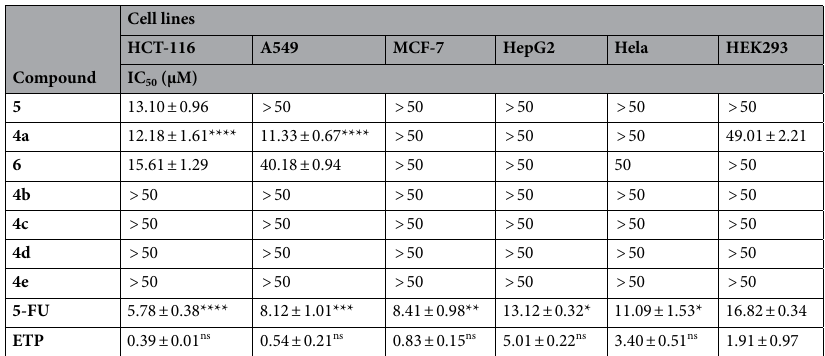
Table 1. Cytotoxic activity of tetrahydroquinoline derivatives against various cancer and normal cells presented as an IC 50 value referring to the concentration that inhibits 50% of cell growth. Data are expressed as the mean ± SD (µM) of n = 3 independent experiments. **** p < 0.00001 in comparison to IC 50 for HEK293 (Student’s